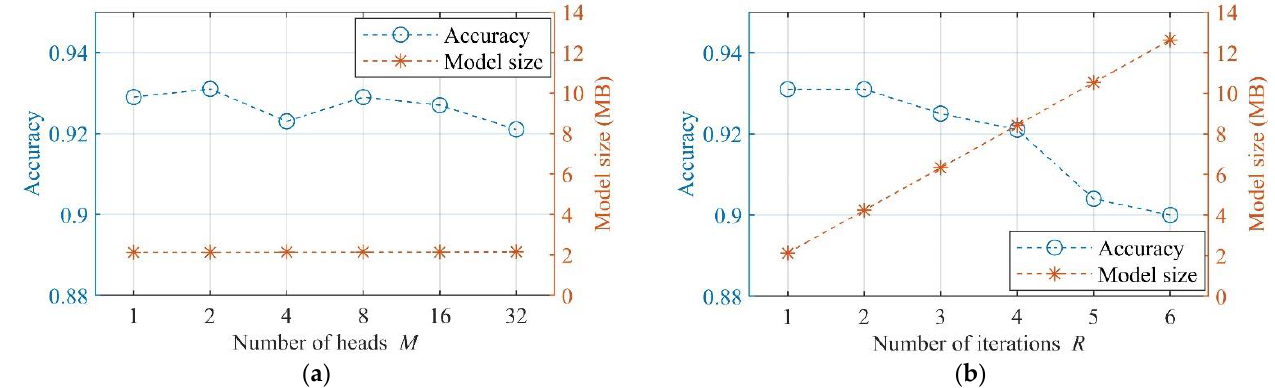
Figure 7. The effect of super parameters on the diagnostic accuracy and model size. ( a ) Number of heads. ( b ) Number of iterations. In ( a ) 𝑅 is fixed as 1, and in ( b ) 𝑀 is fixed as 2.